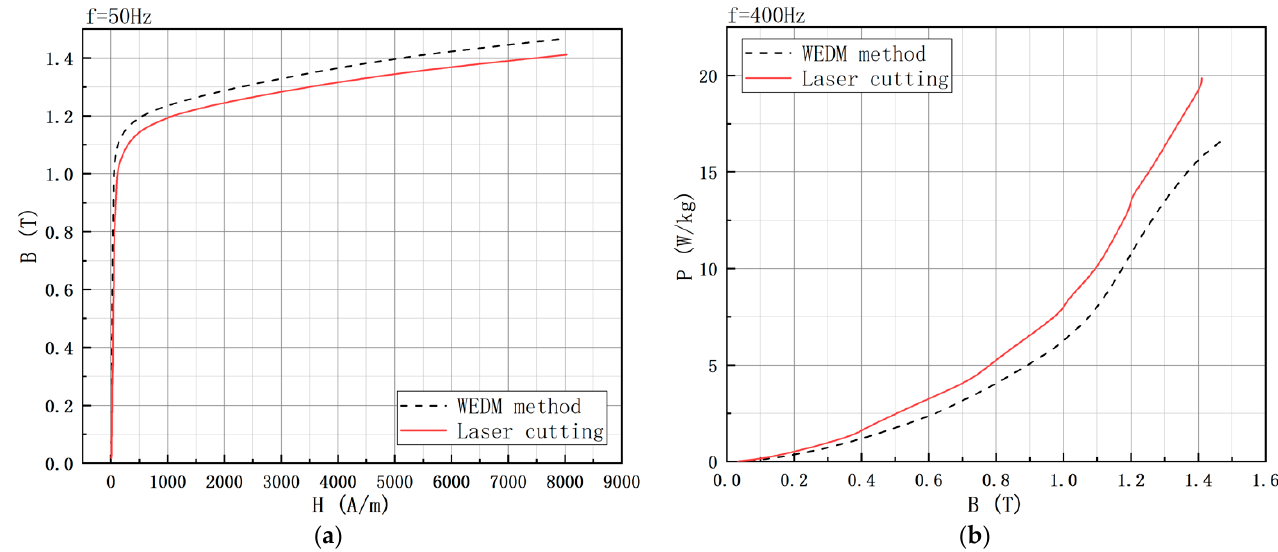
Figure 18. Comparison of magnetic properties of high silicon steel with two different processing methods. ( a ) B-H curve. ( b )B-P curve. methods. ( a ) B-H curve. ( b ) B-P